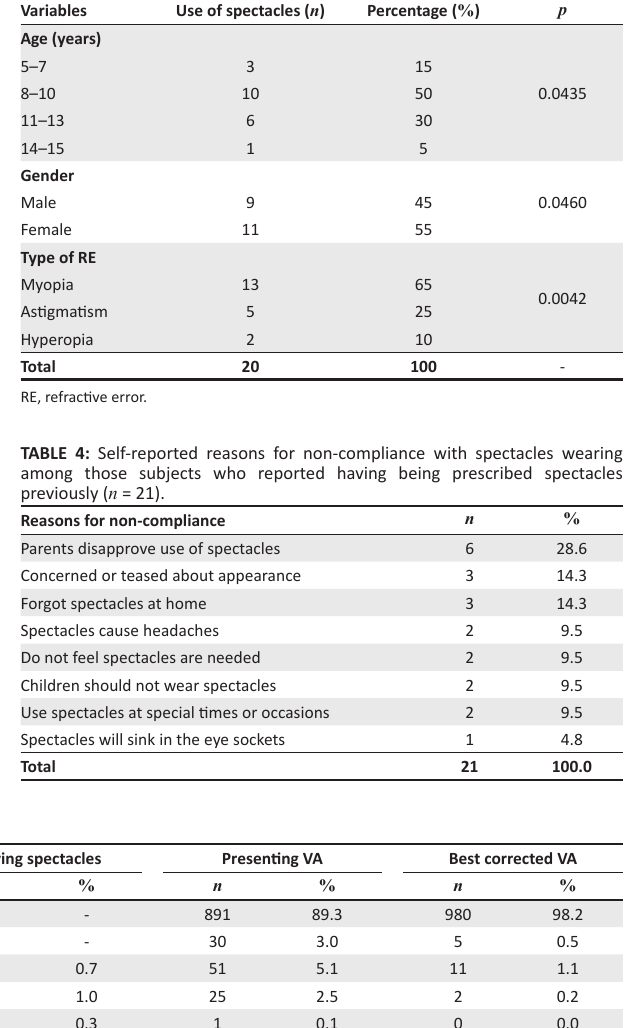
TABLE 3: Spectacles utilisation by age, gender and type of refractive error ( n = 20).